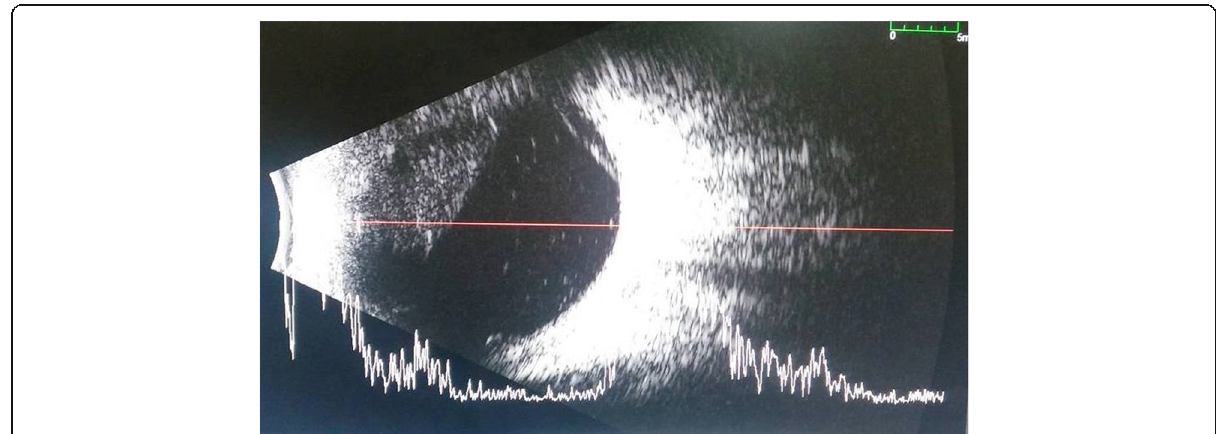
Fig. 5 Day 15 post-laser B-scan ultrasound, axial horizontal documents dense, mobile retrolental/anterior vitreous echoes, mobile dot echoes with increasing amplitude in the mid-posterior vitreous, and a band echo suspicious for exudative retinal detachment on the nasal wall